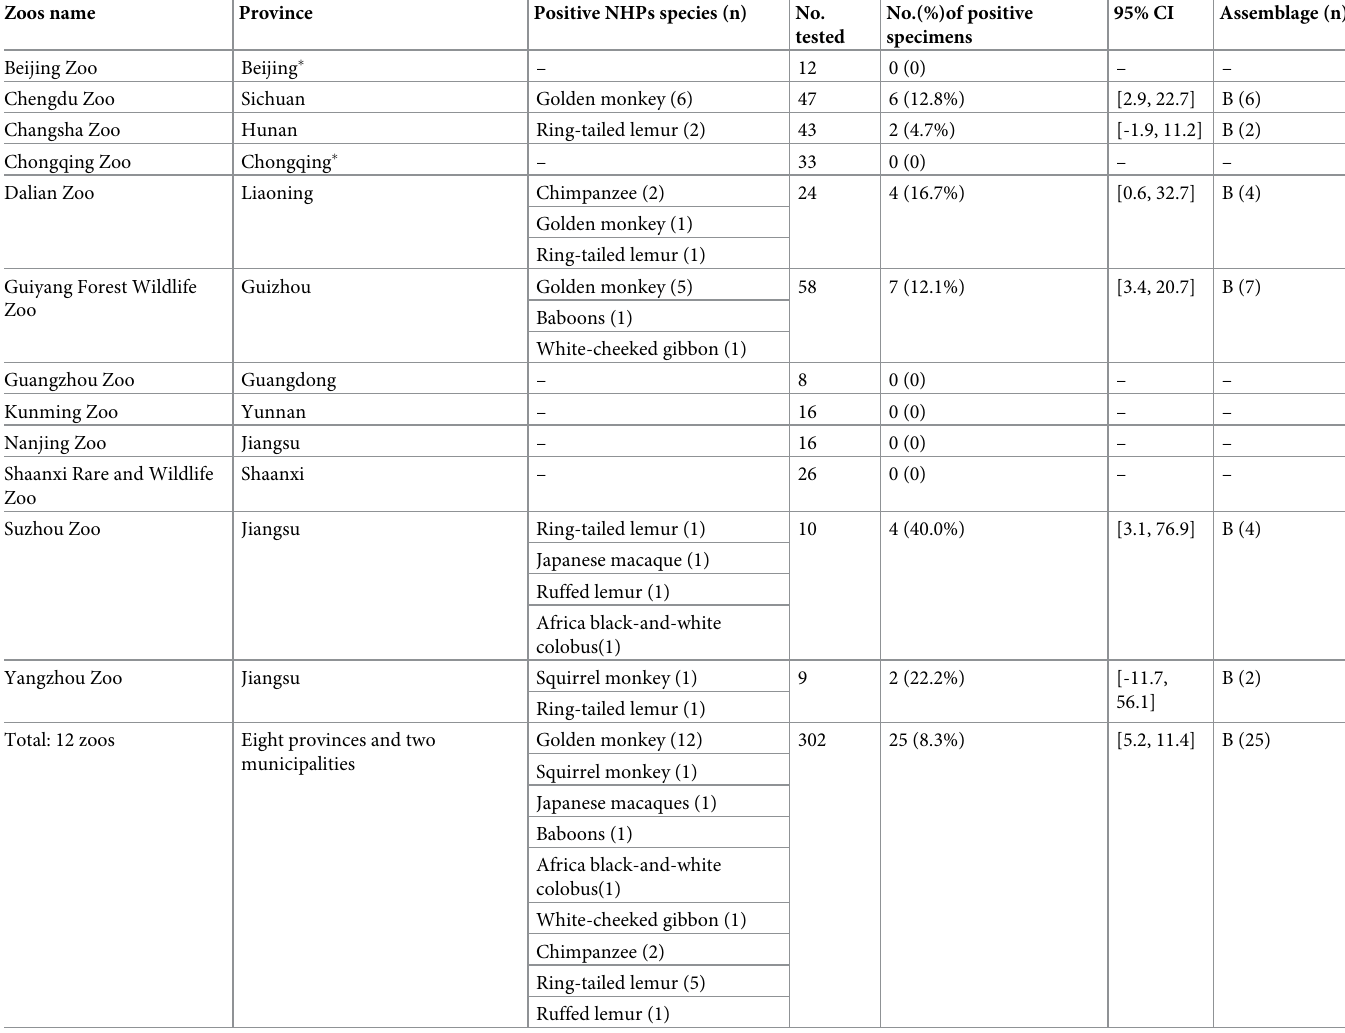
Table 2. Occurrence and assemblage B of G . duodenalis for NHPs from 12 zoos in China. Zoos